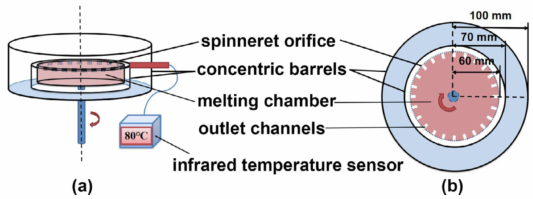
Figure 7. Schematic of the centrifugal melt spinning apparatus: ( a ) perspective view, ( b ) top view. Reprinted with permission from [85]. Copyright © 2020 Elsevier